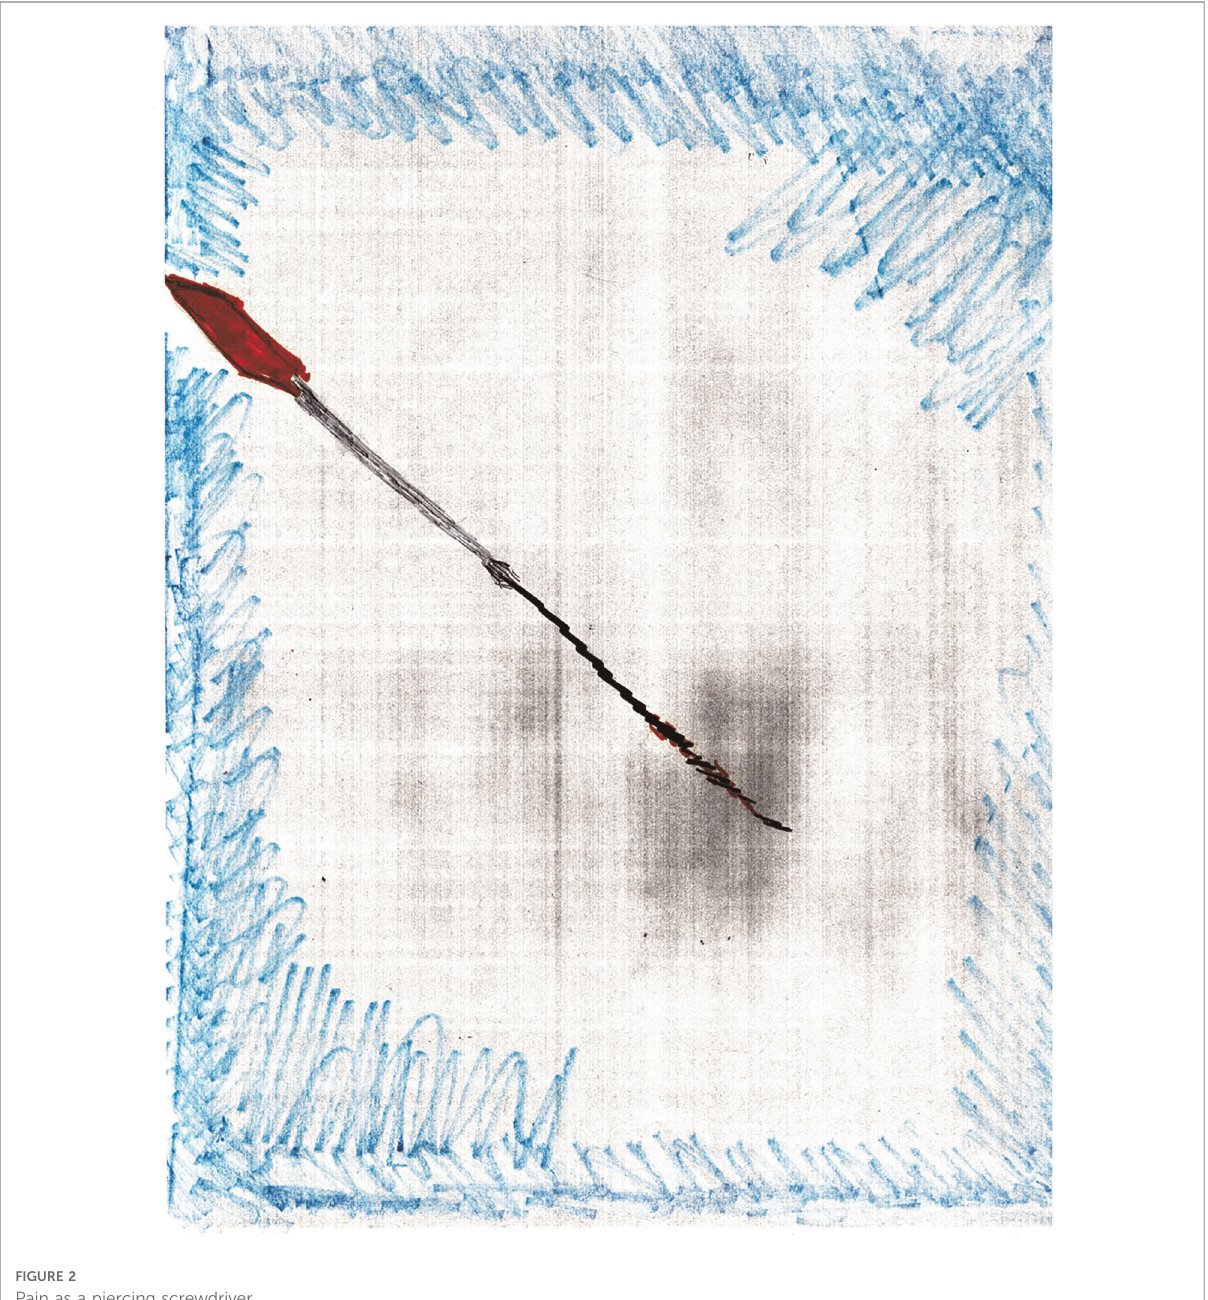
FIGURE 2 Pain as a piercing